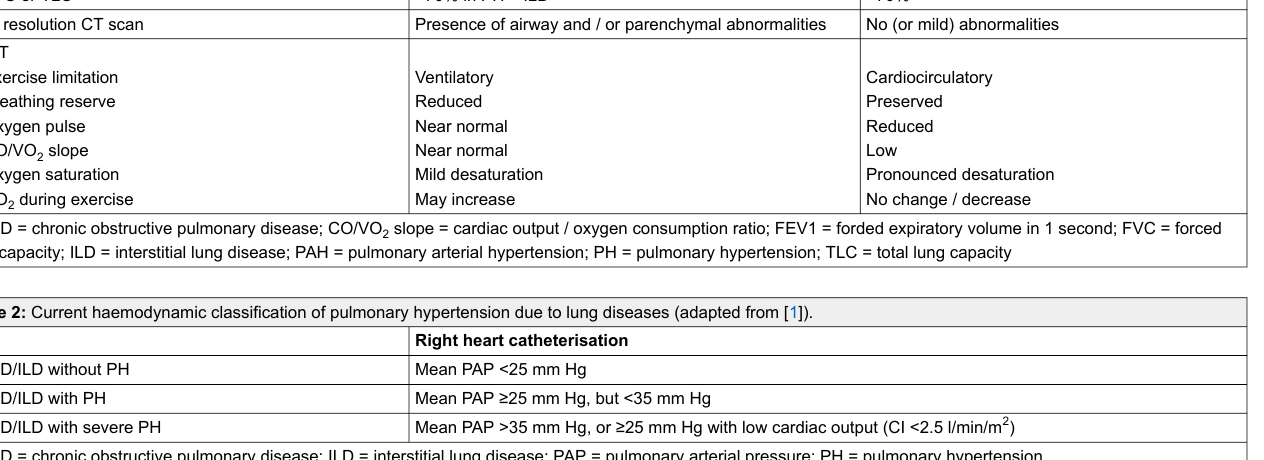
Table 1: Typical findings for lung function, radiology and exercise testing in pulmonary hypertension due to chronic lung diseases and in pulmonary arterial hypertension. PH due to parenchymal lung diseases (Group 3) Lung function FEV1